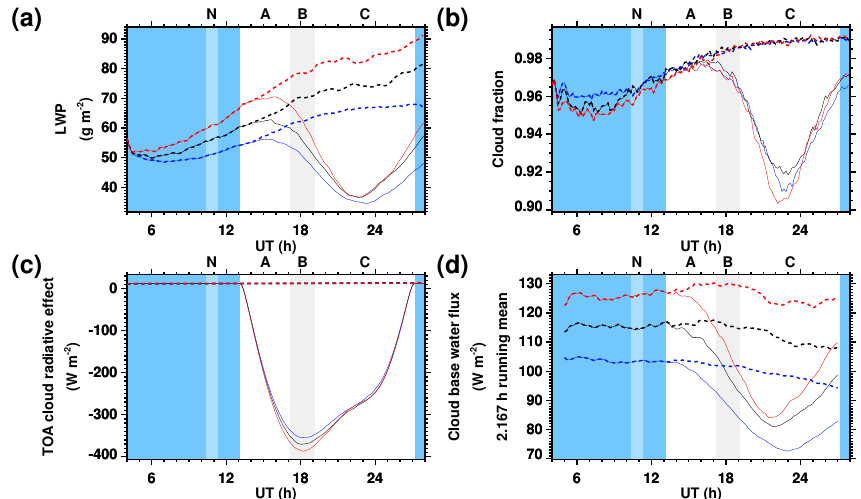
Figure 8. Wind speed and the diurnal cycle. Time series from simulations M − (blue), M 0 (black), M + (red), solid curves, and from simulations M − (blue), M 0 (black), M + (red), dashed curves. A low-pass (running mean) filter was applied where indicated to reduce dark dark dark